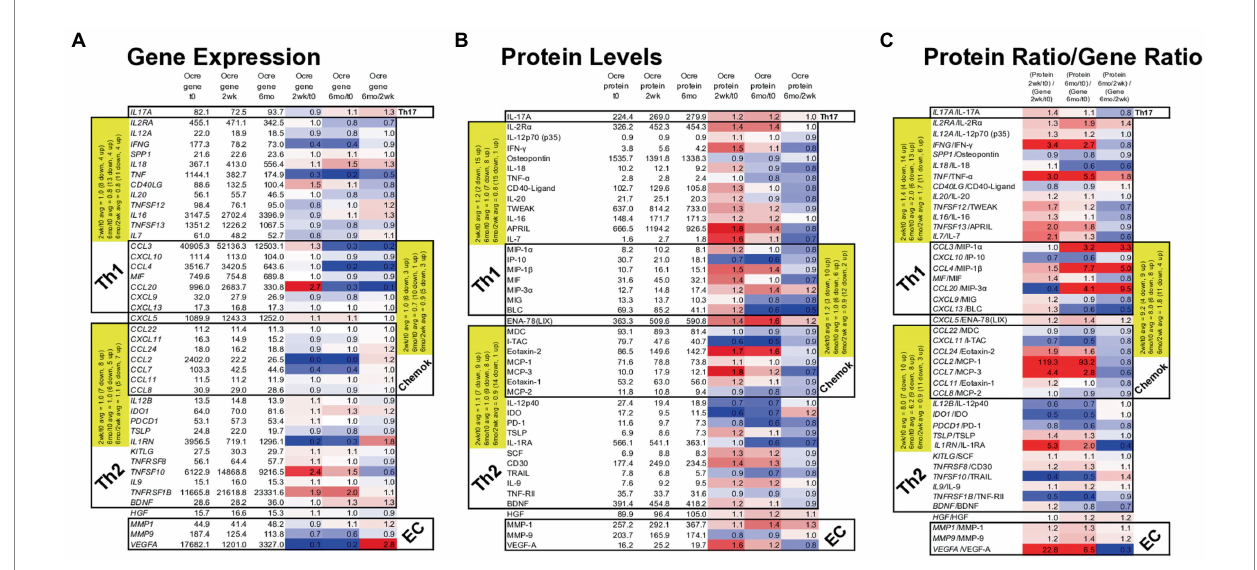
FIGURE 7 Gene expression in MS PBMC and paired serum protein levels of 43 MS-relevant targets at time 0, 2 weeks, and 6 months after ocrelizumab infusion. (A) Gene expression (raw signal, white) change = ratio of at 2 weeks/time 0, 6 months/time 0, and 6 months/2 weeks. (B) Serum protein level (pg/ml) change = level at 2 weeks/time 0; 6 months/time 0, and 6 months/2 weeks; repeated as in (A) . (C) Protein/gene ratio of changes = (protein level at 2 weeks/time 0)/(gene expression at 2 weeks/time 0); repeated as in (A) . Red = protein level change > gene expression change (i.e., ratio > 1.0); blue = protein change < gene change (ratio < 1.0); white = equivalent protein and gene change (ratio = 1.0). Average changes of grouped Th1, Th2, chemokine, and extracellular matrix (EC) markers over time are in yellow. Genes in italics; proteins in upright font. Red = increase; blue = decrease. The Th1 cluster includes myeloid and other cell products that induce Th1 cells and which are inflammatory in the context of MS. Similarly, Th2 includes proteins that are anti-inflammatory in the MS